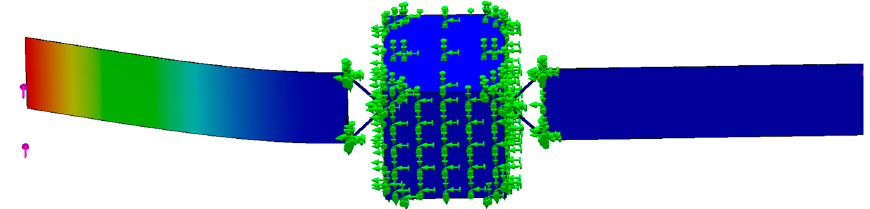
Figure 10. Whole star flexible solar wing frequency analysis. (The green symbol in the figure represents the constraint, and the pink arrow represents the external disturbance.)